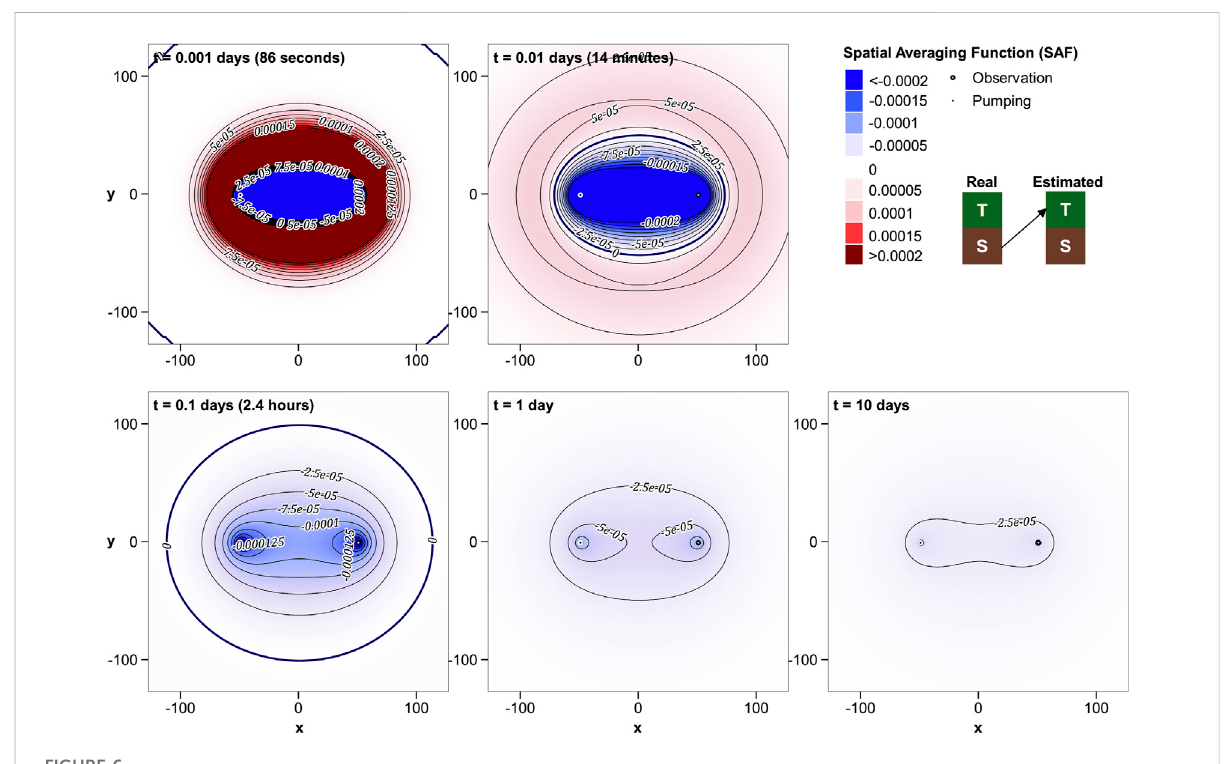
FIGURE 6 R ′ T − S for separated wells at fi ve different